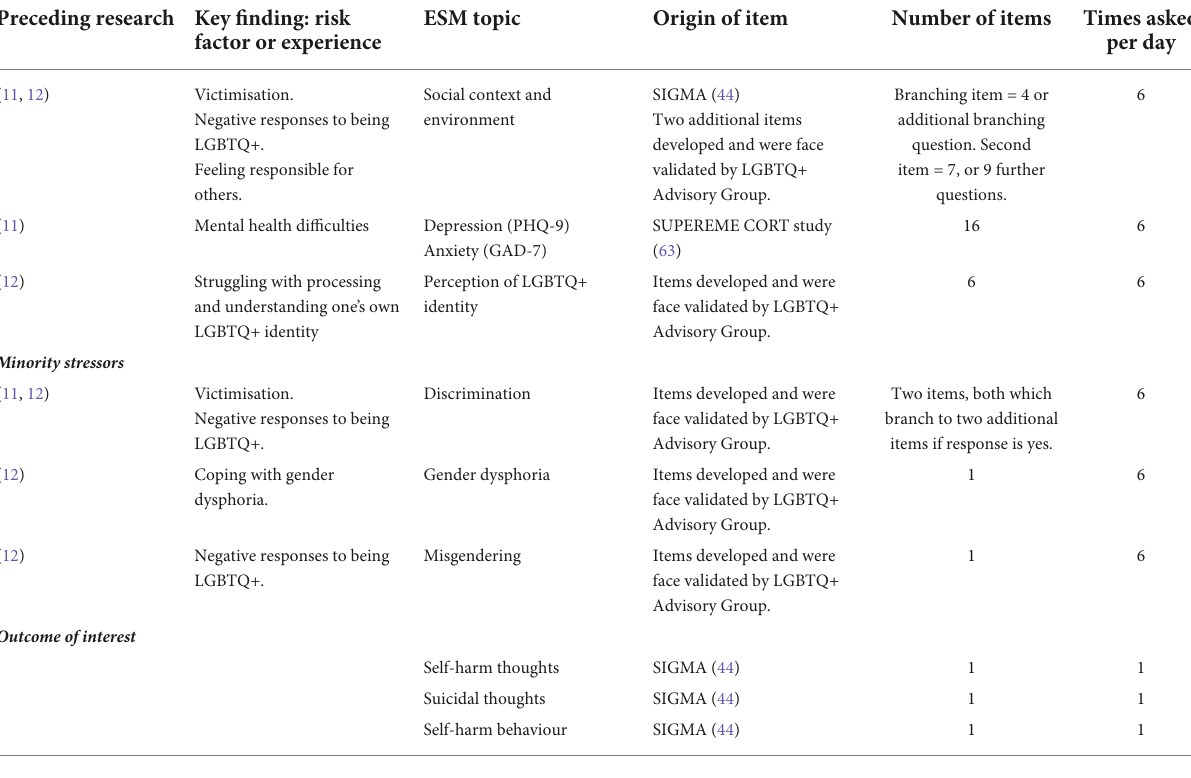
TABLE 1 Overview of all experience sampling method (ESM) items.